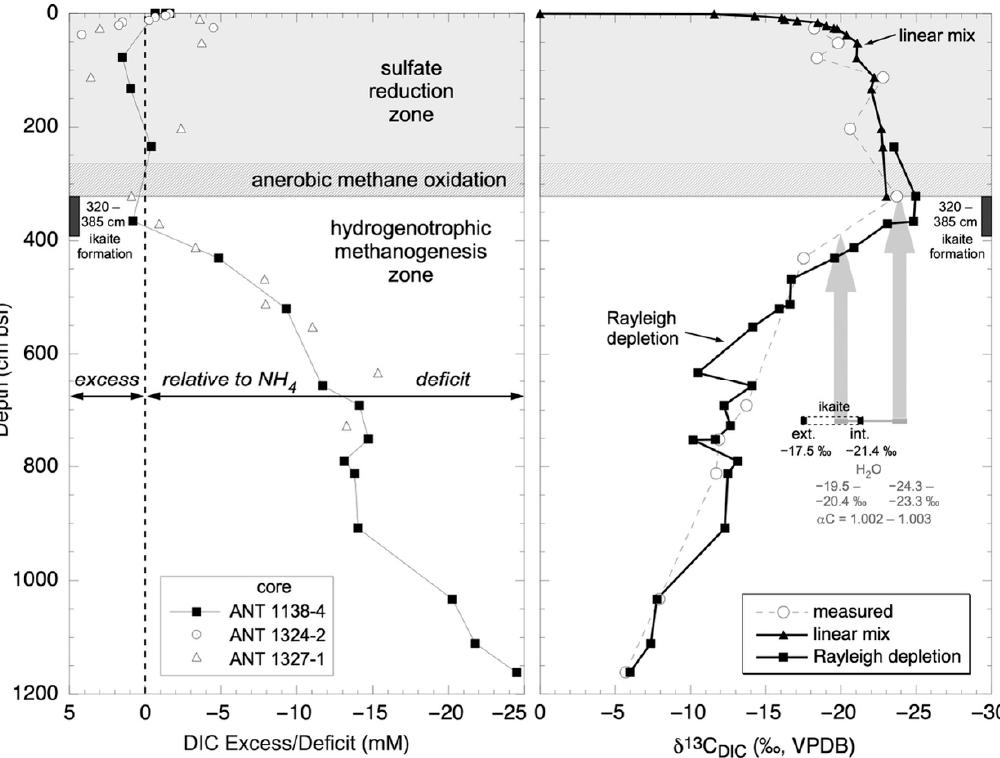
Figure 6. (Left panel) Calculated DIC excess and deficit (beneath SRZ) based on a conservative DIC:NH 4 stoichiometry model, assuming that the NH 4 concentration is only affected by addition through remineralization and the reference C:N is 1:0.045 (Equation (8)) in the SRZ. The loss in DIC is due to uptake by methanogens. (Right panel) Measured (open circles) and modeled δ 13 C DIC depth distributions using a combination of: (1) mixing line in the SRZ (closed triangles), which indicates DIC input from microbial sulfate reduction and buried oceanic DIC (Equation (5)), and (2) Rayleigh-based carbon isotope fractionation of DIC by methanogen utilization (Equations (7) and (9)) beneath the SRZ. The current depth of ikaite occurrence is shown along with the measured profile range in δ 13 C δ 13 C α C DIC expected based on the ikaite along with the range in ikaite-H2O range of 1.002 to 1.003. The “ext.” and “int.” are the δ 13 C ikaite for the interior and exterior of the crystal (Section